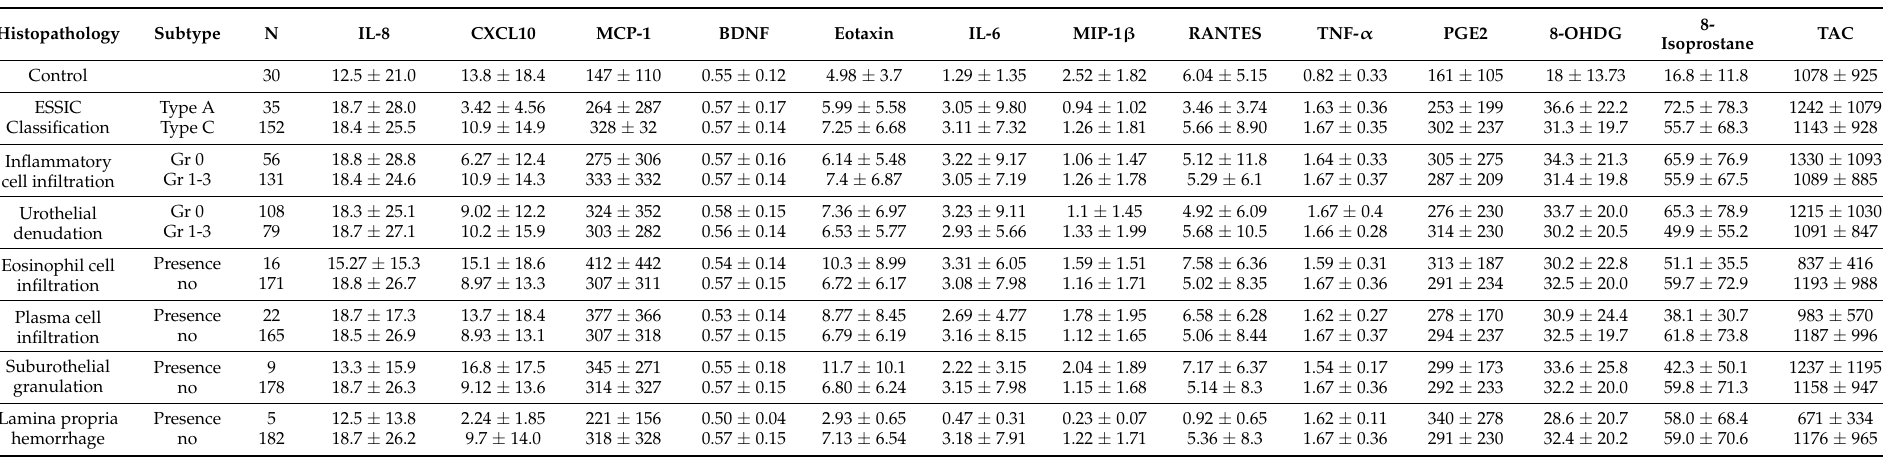
Table 5. Association between urinary biomarker levels and ESSIC classification and specific bladder histopathological findings in patients with non-Hunner’s interstitial